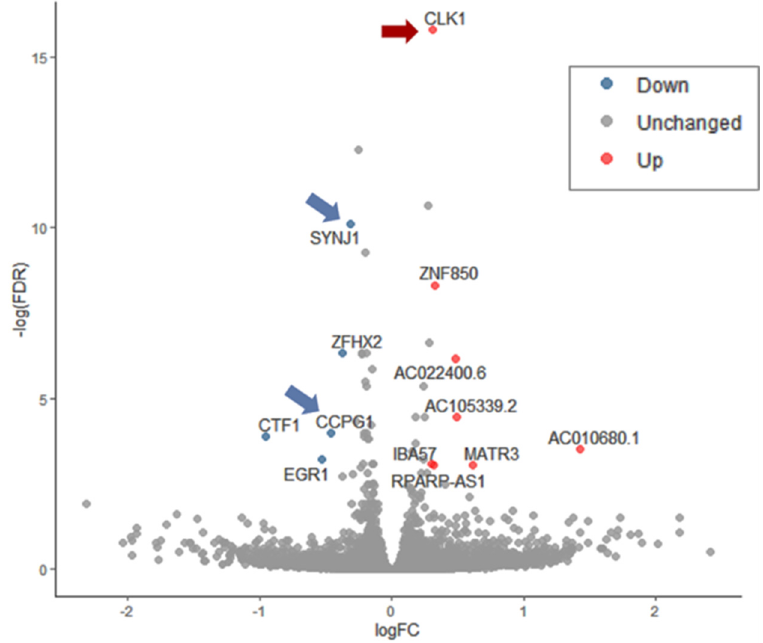
Figure 6. A volcano plot of differential gene expression as a result of pre-incubation (2 h) with ladostigil in the presence of Sin1 (24 h) compared to cells that were exposed to Sin1 alone. Each experimental group includes three biological replicates. RNA-seq reads were processed by a statistical model (using the edgeR, see Materials and Methods) and represented by the log FC (fold change) with FDR < 0.05. Arrows mark the statistically significant genes that function in oxidative and ER stress response.